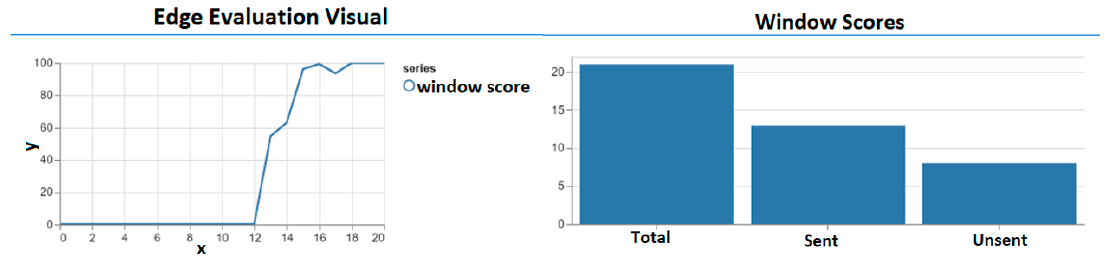
Figure 10. Evaluation of the performance of the model evaluation algorithm on the smartphone (left) (y-axis represents the window score and the x-axis represents the window identity) and the evaluation of the communication overhead by the amount of data sent to the cloud (right).